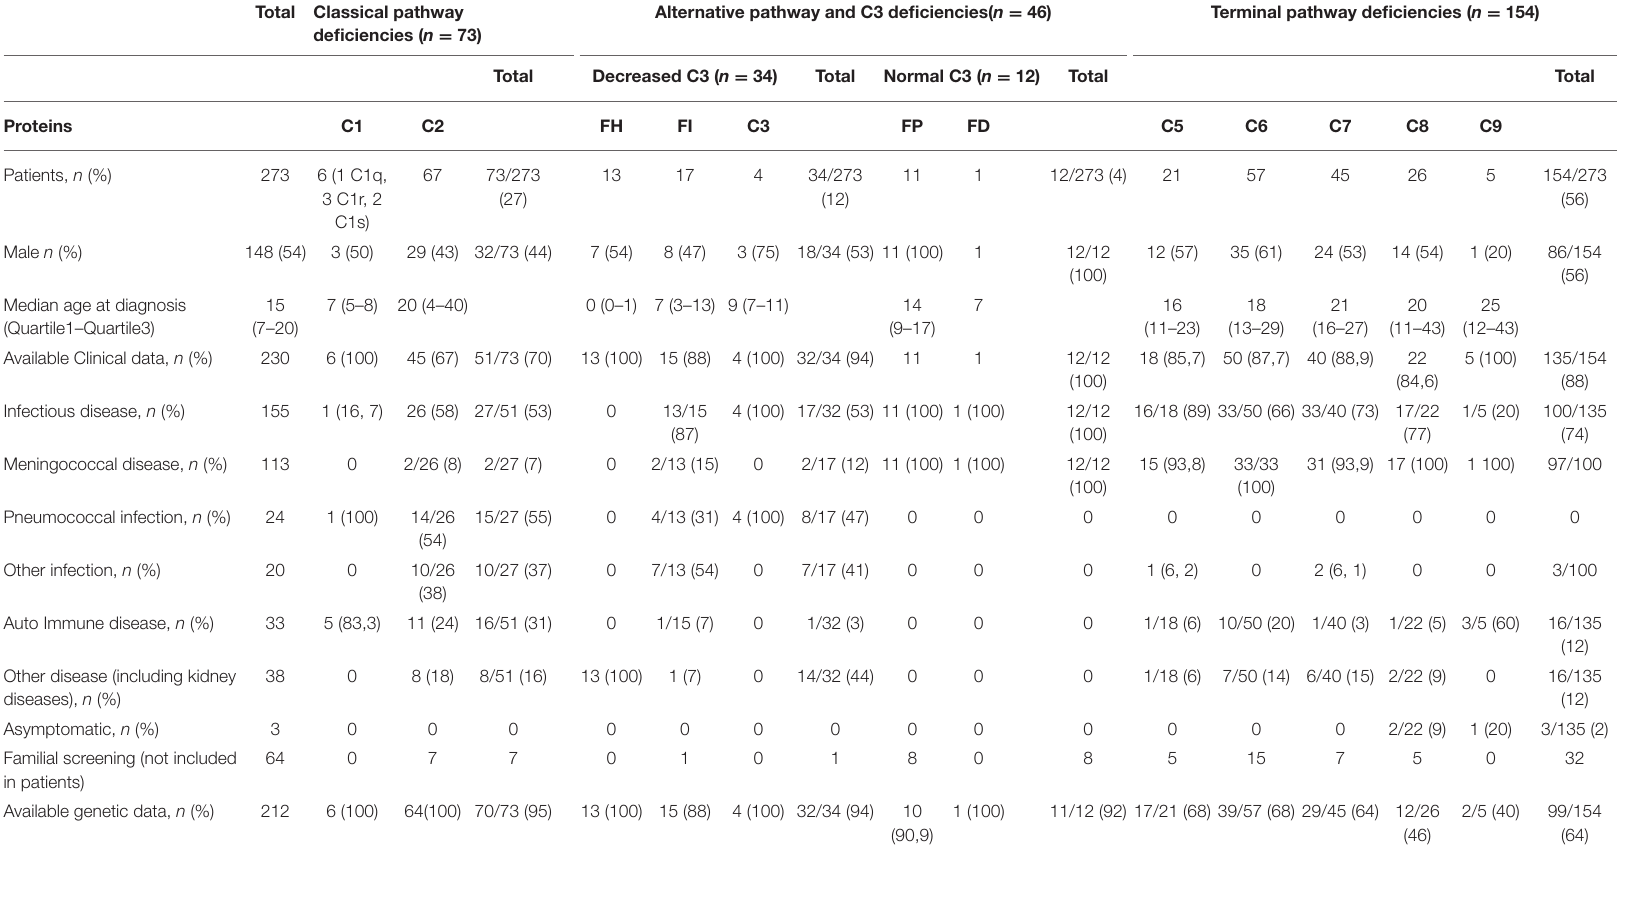
TABLE 1 | Clinical characteristics of patients with complement